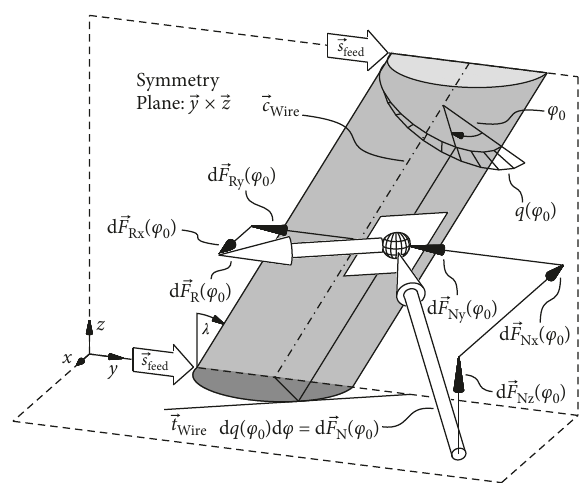
Figure 11: Half symmetrical sketch of the acting forces and their Cartesian components on the surface of an oblique wire. The angle of the slope is indicated by λ . The feed direction is rep- resented by s feed . The line load q ( φ 0 ) describes the load along the wire circumference. For a specific φ 0 , the normal force d F N ( φ 0 ) at the incremental contact point is represented in perpendicular direction to the wire surface. The tangential wire surface is de- scribed by the tangent t Wire and the rotation axis of the wire c Wire . The friction force d F R acts in the direction of t Wire . The forces d F N ( φ 0 ) and d F R ( φ 0 ) are also given in their Cartesian components.